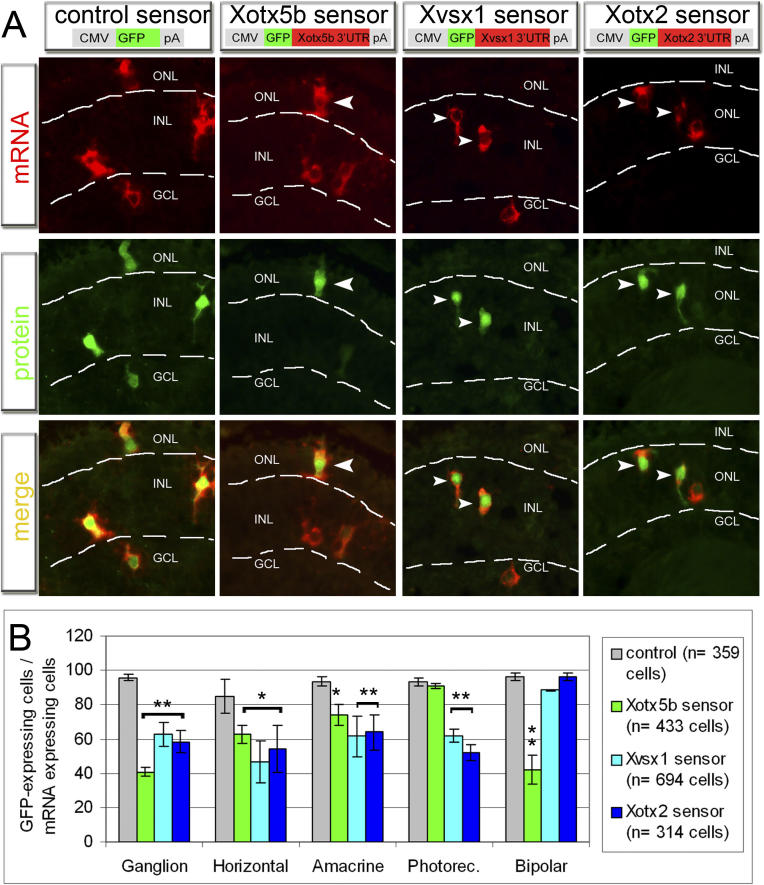
The 3′ UTRs of Xotx5b, Xvsx1, and Xotx2 mRNA Direct Cell Type–Specific Inhibition of Translation(A) Detection of sensor mRNAs (Fast Red), sensor GFP protein (green immunodetection), or co-detection of both mRNA and protein (merge, yellow), in cells of mature retinas (st. 42) lipofected with GFP control vector, or UTR-carrying sensor vectors (see Materials and Methods). Unlike control GFP, sensor GFP translation is detectable (arrowheads) mainly in photoreceptors (Xotx5b sensor) or bipolar cells (Xvsx1 and Xotx2 sensors). ONL: outer nuclear layer; INL: inner nuclear layer; GCL: ganglion cell layer.(B) Bars show the proportion of sensor-translating/sensor-transcribing cell types. Number of cells is indicated by n. Error bars represent standard error of the mean. Single asterisk indicates p ≤ 0.05; double asterisk indicates p ≤ 0.01 (student's t-test).